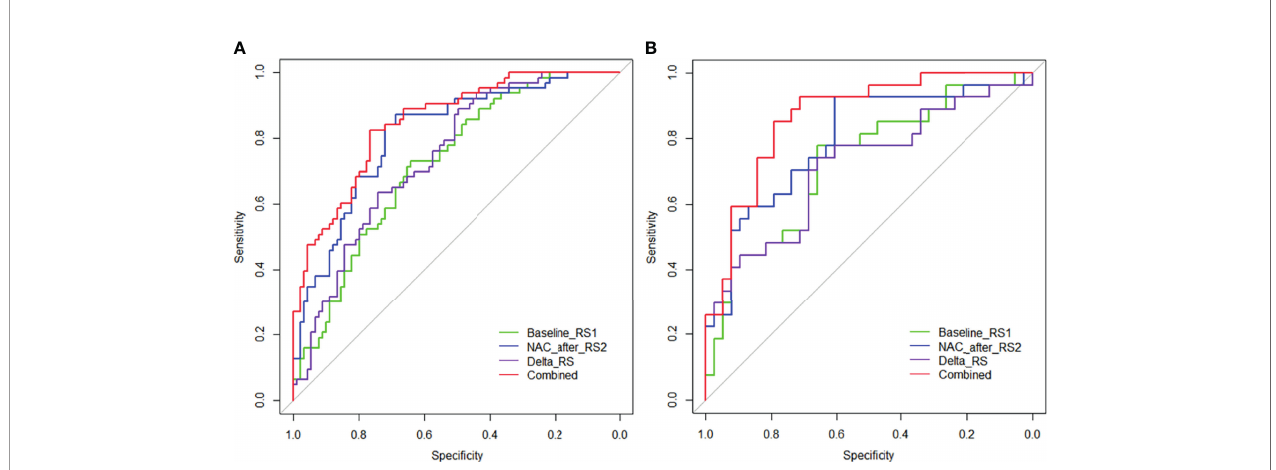
TABLE 4 | Multivariable logistic regression analysis of risk factors of NAC responders. Characteristic